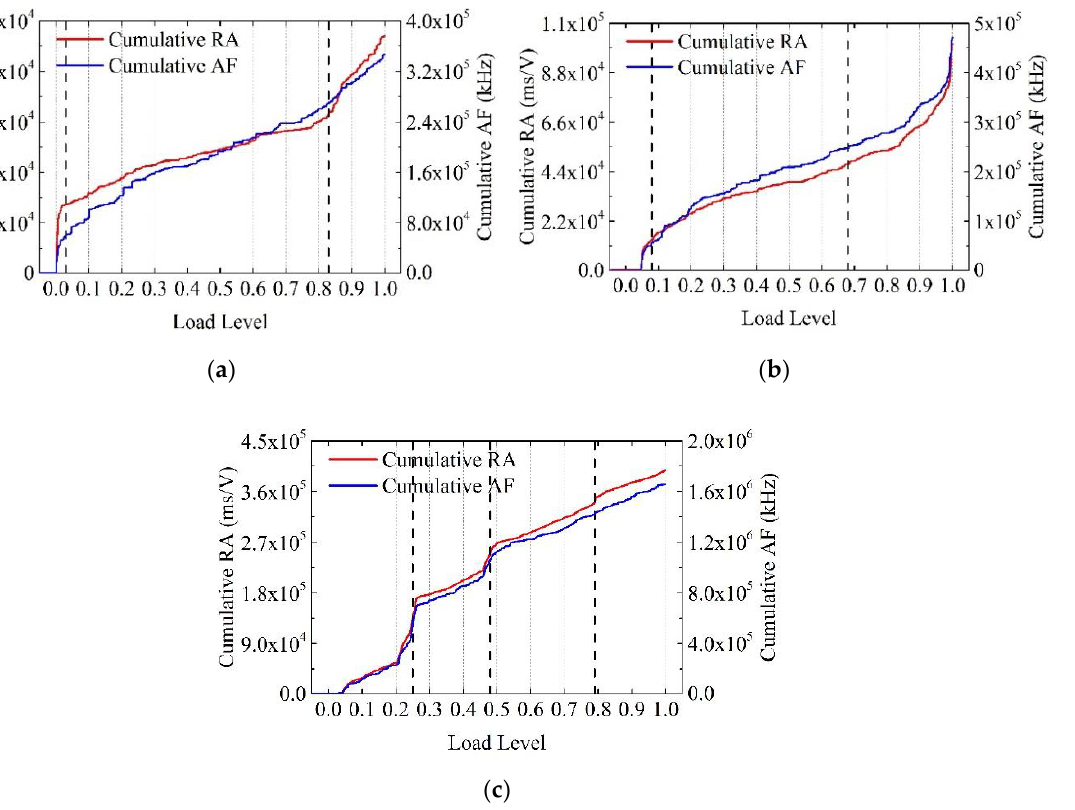
Figure 11. Cumulative RA and average frequency: ( a ) basalt fiber content of 6 kg/m³; ( b ) basalt fiber content of 10 kg/m³; and ( c ) basalt fiber content of 14 kg/m³.